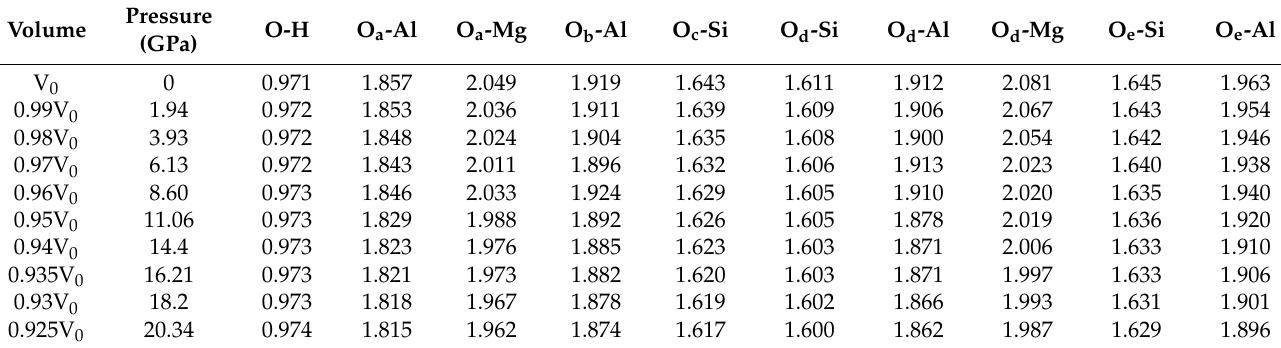
Table 9. The bond lengths (Å) in optimized structure of the Mg-MMT under pressure.